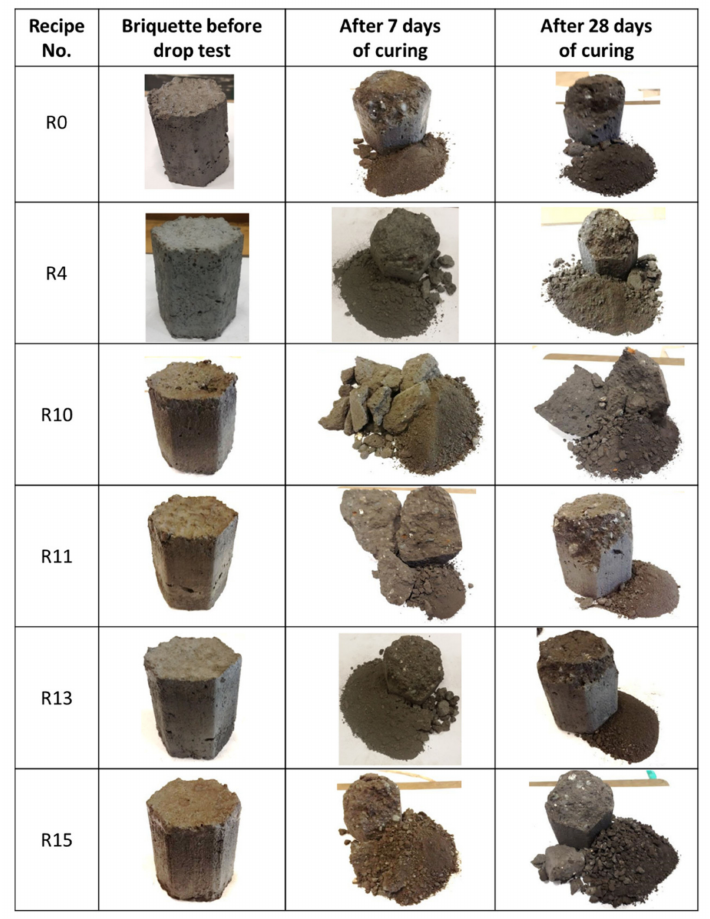
Figure 2. Photomacrograph of the briquettes after drop